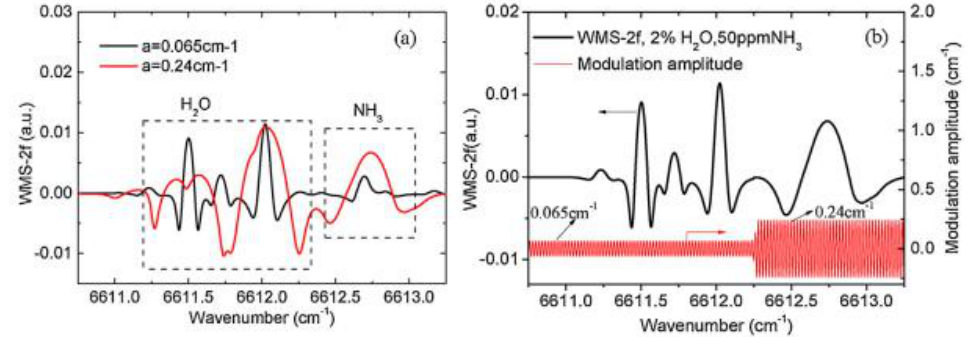
Figure 9. Simulated WMS-2 f signal with ( a ) modulation amplitude 0.065 cm −1 and 0.24 cm −1 , respectively; ( b ) wavelength modulation spectroscopy with varied modulation amplitude (WMS-VMA). Figure adapted from [95].